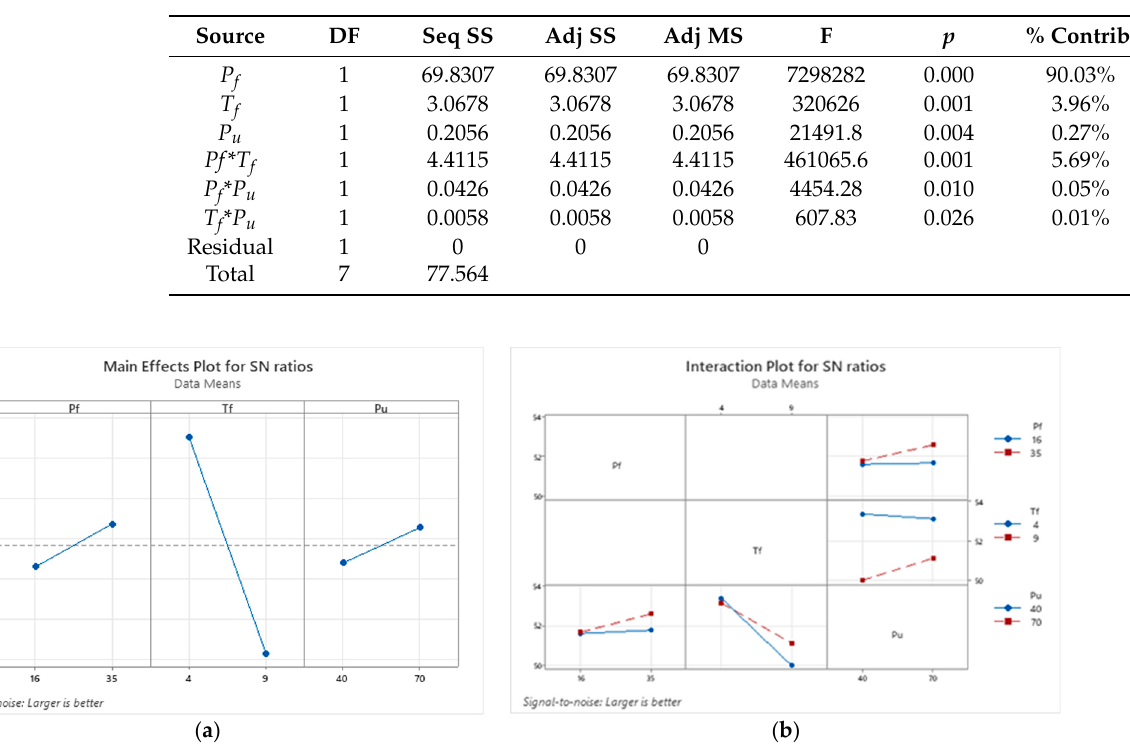
Figure 10. Low-carbon steel–304 SS main effect ( a ) and interaction ( b ) plots for SNR.